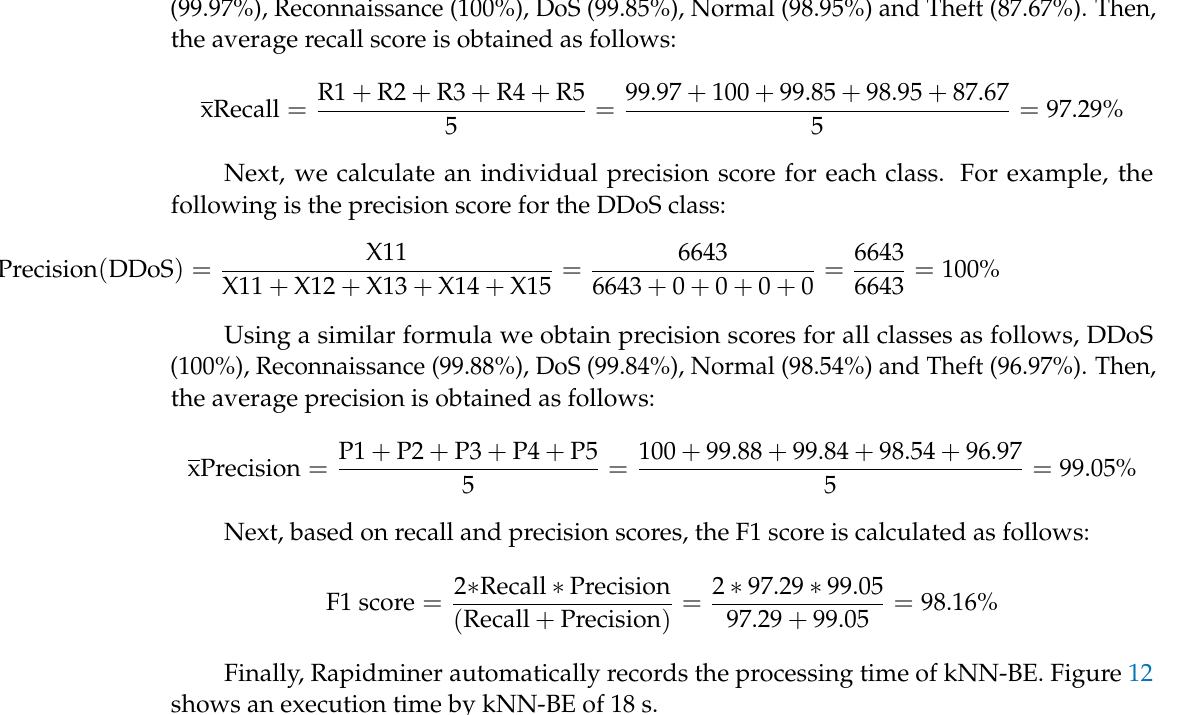
Figure 12. Execution time for kNN-BE.